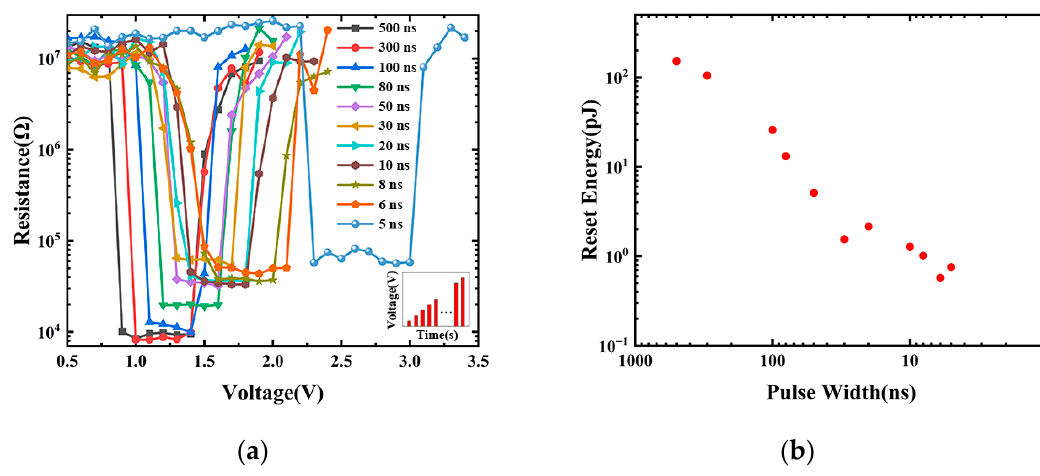
Figure 9. ( a ) The R-V electrical test of the prototype PCRAM device based on C-Sb 2 Te 3 material, and ( b ) the relationship between power consumption and pulse width.